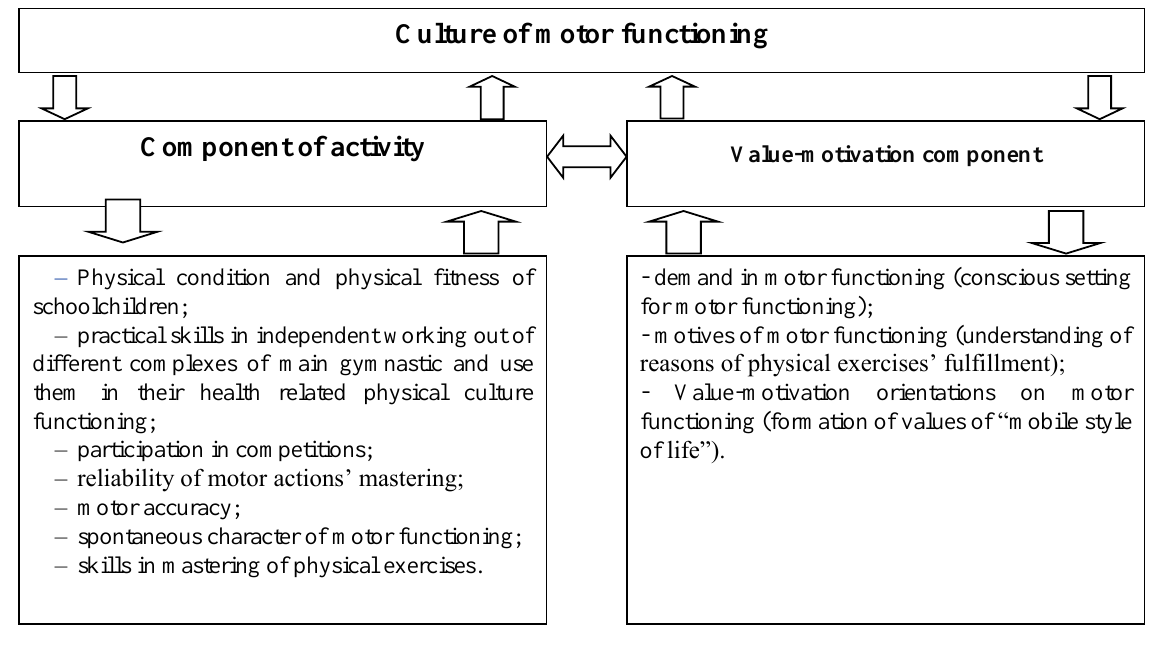
Fig.1. Culture of motor